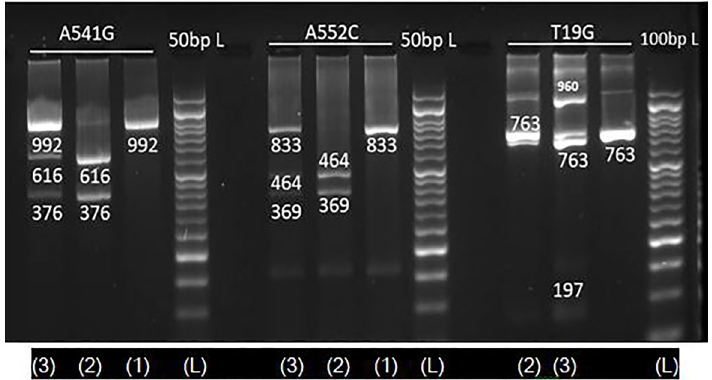
Figure 1. Electrophoresis gel image patterns of UGT1A6 (A541G, A552C, T19G) gene after digestion with NsiI , Fnu4 HI, and Hha I, respectively. L: Ladder; lane (1): homozygosity for variant allele; lane (2): homozygosity for common allele; lane (3):